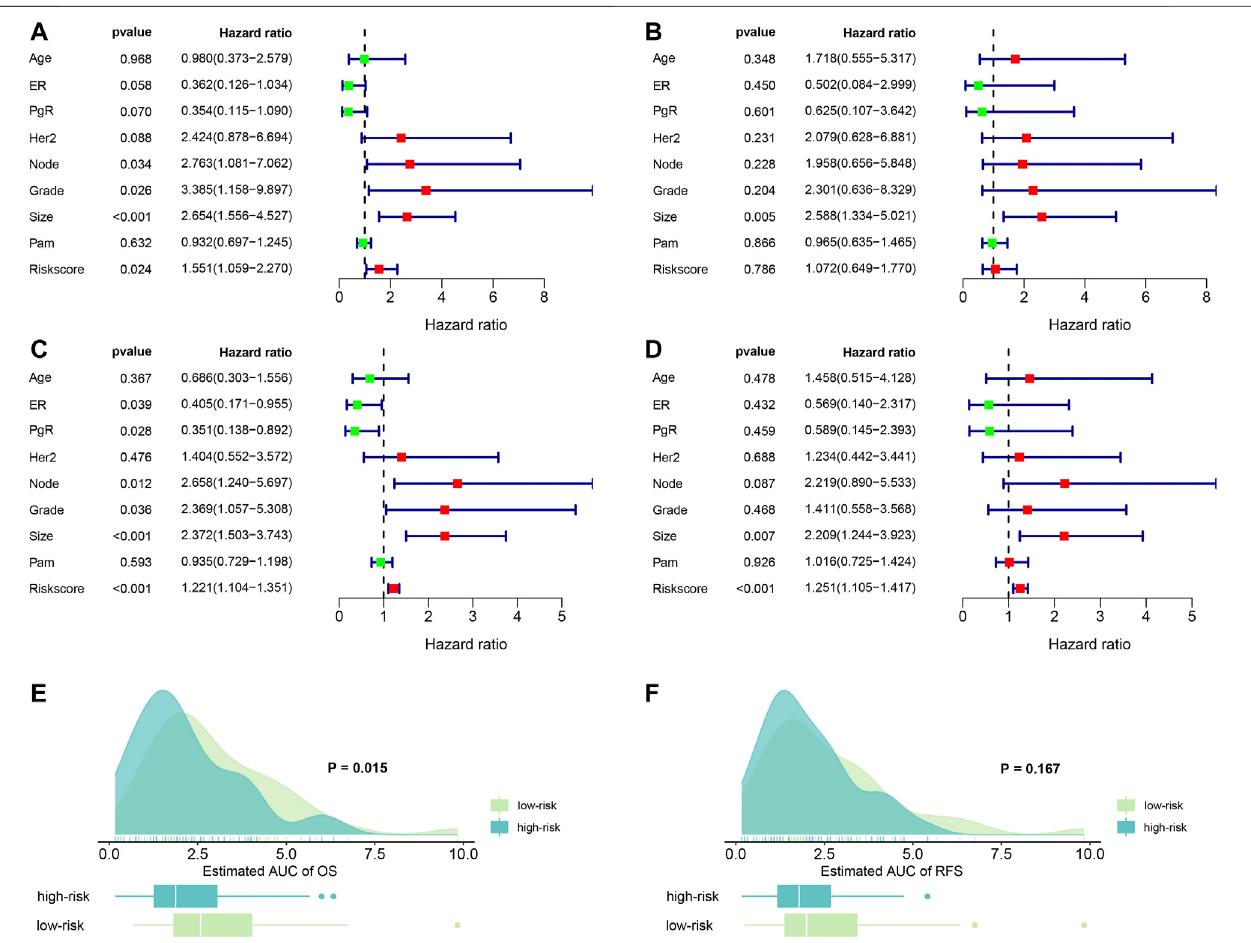
FIGURE 3 | Forest plots of independent risk factors and survival prediction. (A) univariate Cox regression analysis for OS. (B) Multivariate Cox regression analysis for OS. (C) Univariate Cox regression analysis for RFS. (D) multivariate Cox regression analysis for RFS. (E) OS prediction of the estimated AUC using the risk score. (F) RFS prediction of the estimated AUC using the risk score. ER: estrogen receptor; PgR: progesterone receptor; node: lymph node number; Grade: tumor grade; size: tumor size; PAM: a classi fi cation method.